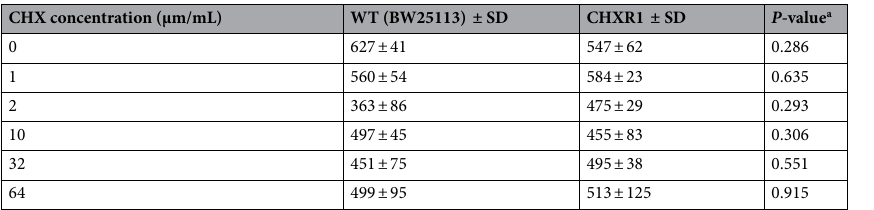
Table 2. Mean cell counts with standard deviation (SD) for WT and CHX-adapted E. coli (CHXR1) cells visualized and averaged from 4 different 1000× magnification SEM images per sample at increasing CHX concentrations after 30-min of drug exposure. a P -values were determined using a two-tailed Students t-test comparing WT to CHXR1 for each CHX concentration.